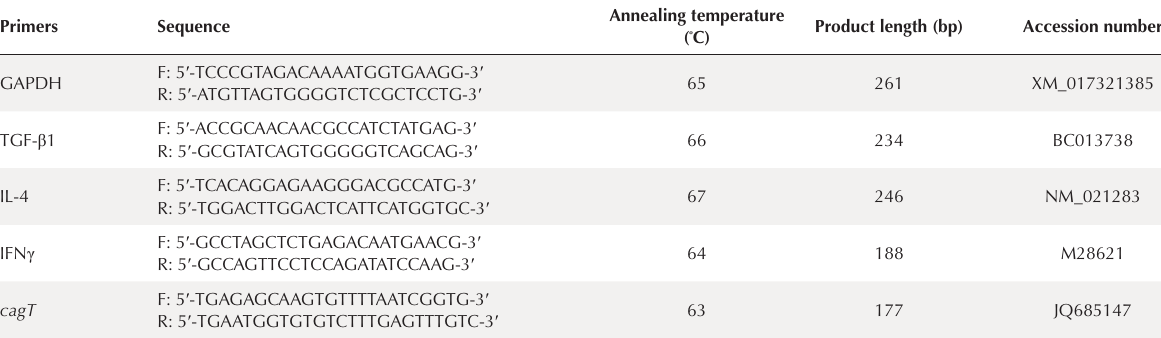
Table 1. The applied primer sequences for q-RT-PCR